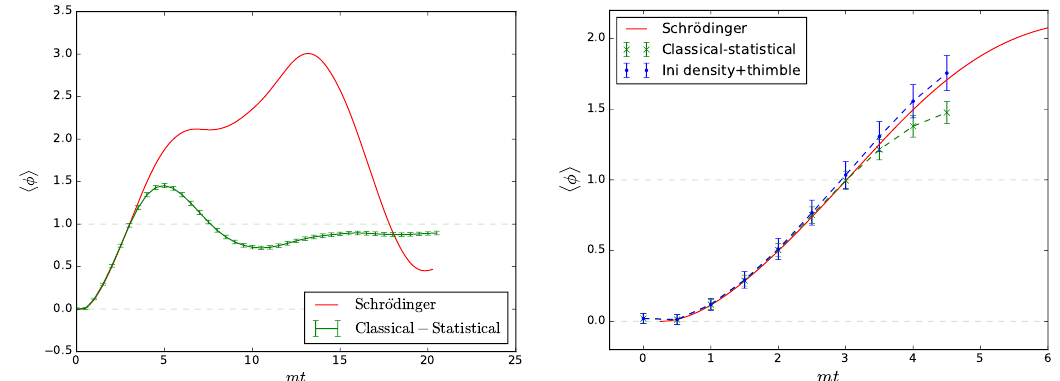
Figure 4 . Results of the simulations with g = 0 : 3 for: full Schr(cid:127)odinger evolution (left, solid curve); classical-statistical approximation (left, curve with 1 (cid:27) statistical error bars); a comparison of all three methods, Schr(cid:127)odinger, classical-statistical and initial density plus thimble, over a reduced evolution time.